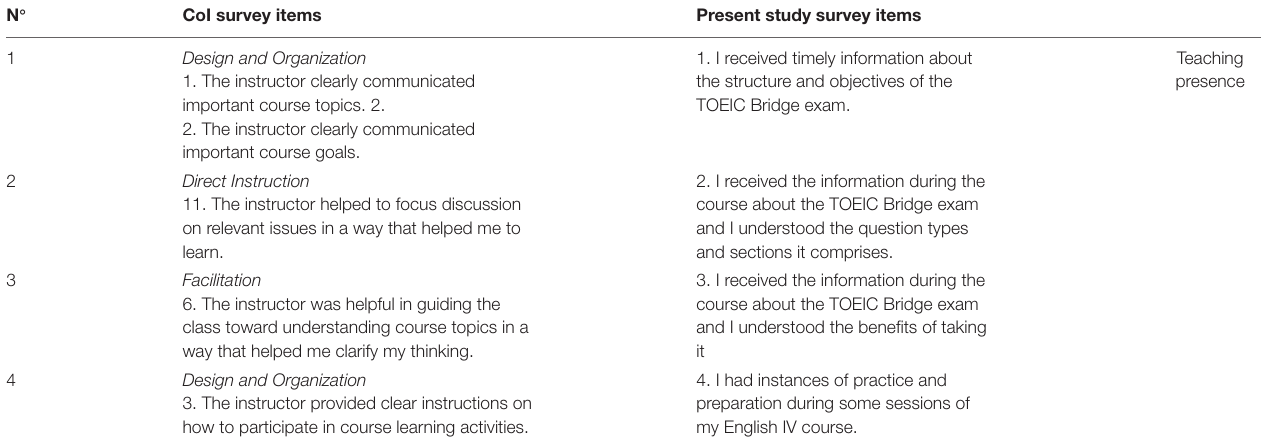
TABLE 1 | Survey item alignment and teaching presence.